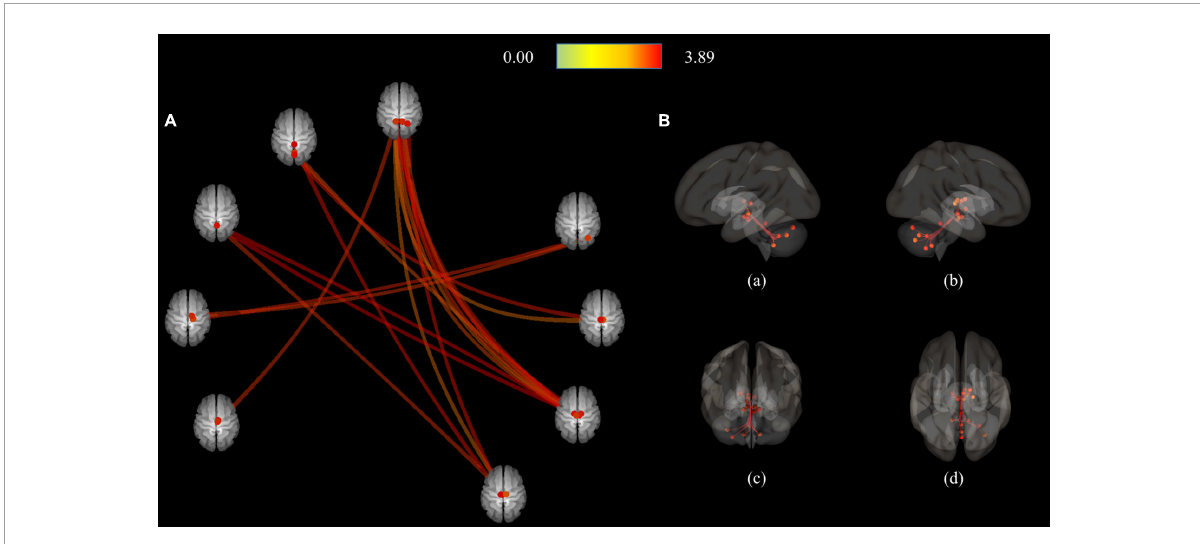
FIGURE2 Connection pairs of HC > MDD functional connectivity within 71 ROIs for the ROI-to-ROI analyses. (A) ROI-to-ROI connectome ring maps (B) ROI-to-ROI 3D rendering maps on the left (a), right (b), anterior (c), and superior view (d). The color bar indicates the statistical T -value. HC, Healthy controls; MDD, Major depressive disorder; ROI, Region of